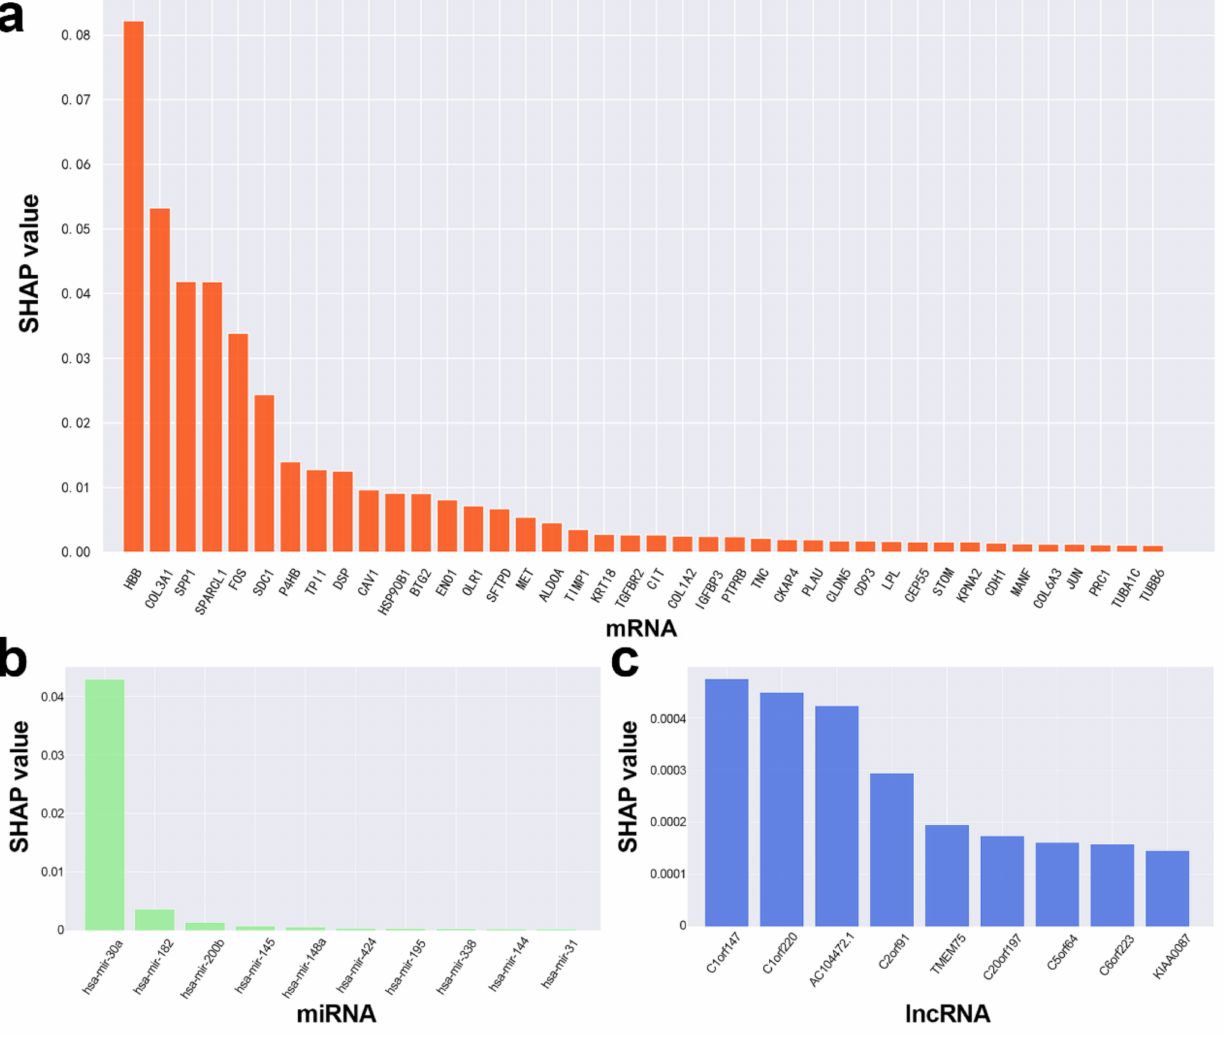
Figure 7. The SHAP values of top RNAs with SHAP value > 0.0001 in the ceRNA DNN model: ( a ) Top 40 mRNAs, ( b ) top 10 miRNA, and ( c ) top 9